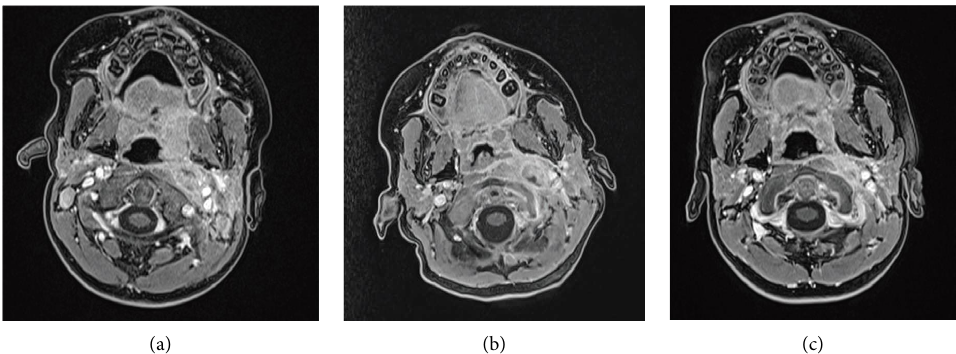
Figure 3: (a) Retropharyngeal space colliquation area on frst admission. (b) Retropharyngeal space colliquation area on second admission. (c) Retropharyngeal space after